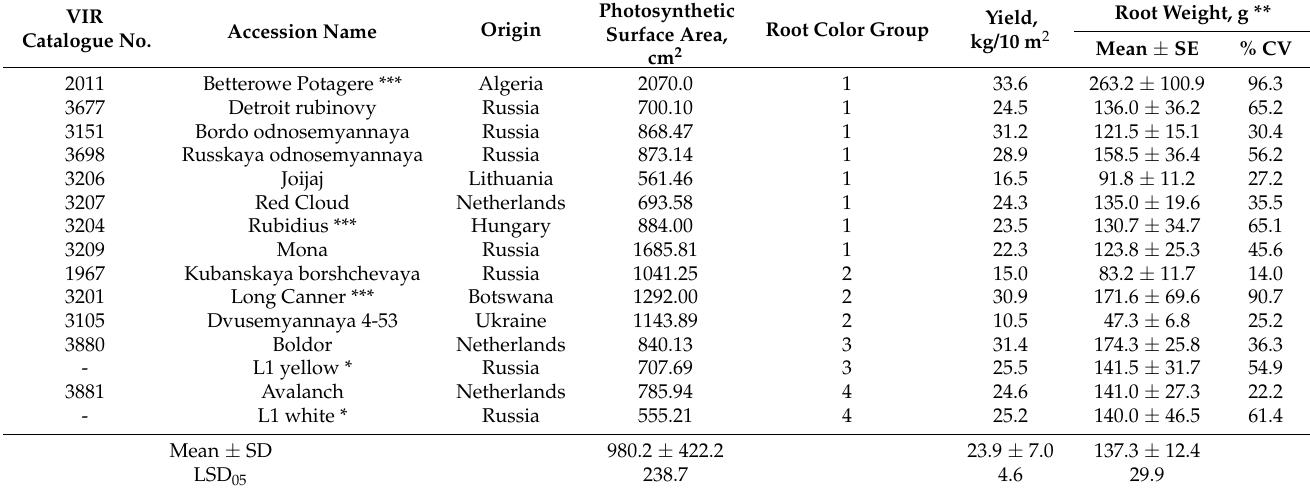
Table 1. Productivity characteristics of table beet accessions. Duration of the growing season: 105 days. Results are presented as mean values with a standard deviation (Mean ± SD), the coefficient of variation (%CV), mean values with standard error (Mean ± SE), and the least significant difference (LSD 05 ).